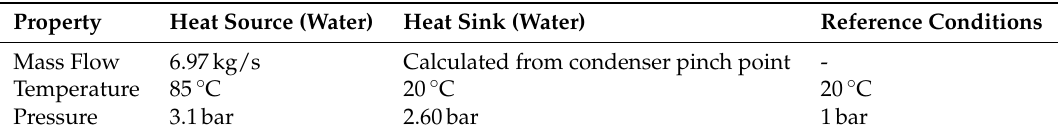
Table 1. Reference case for heat source and heat sink.